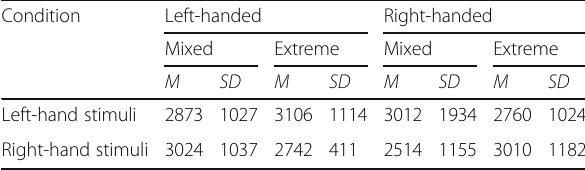
Table 4 Descriptive statistics for reaction time of same-hand/ same-gesture